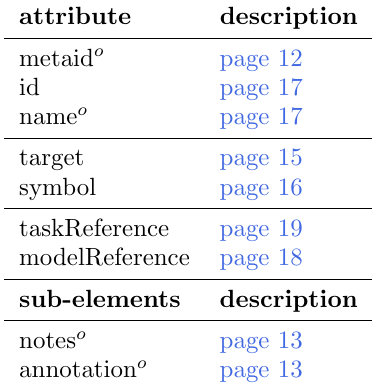
Attributes and nested ele- ments for Variable. o denotes optional elements and